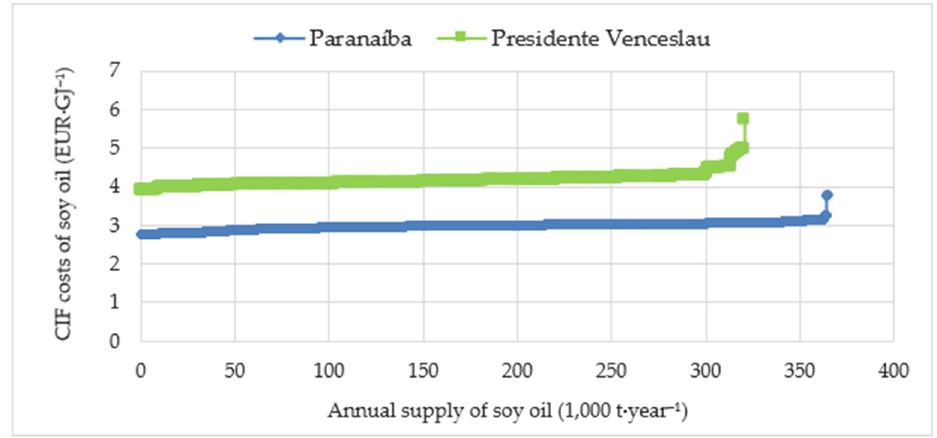
Figure 10. Estimated supply curves of soy oil at REPLAN, for Case 2b, from two new producing regions: Paranaíba (MS) and Presidente Venceslau (SP).